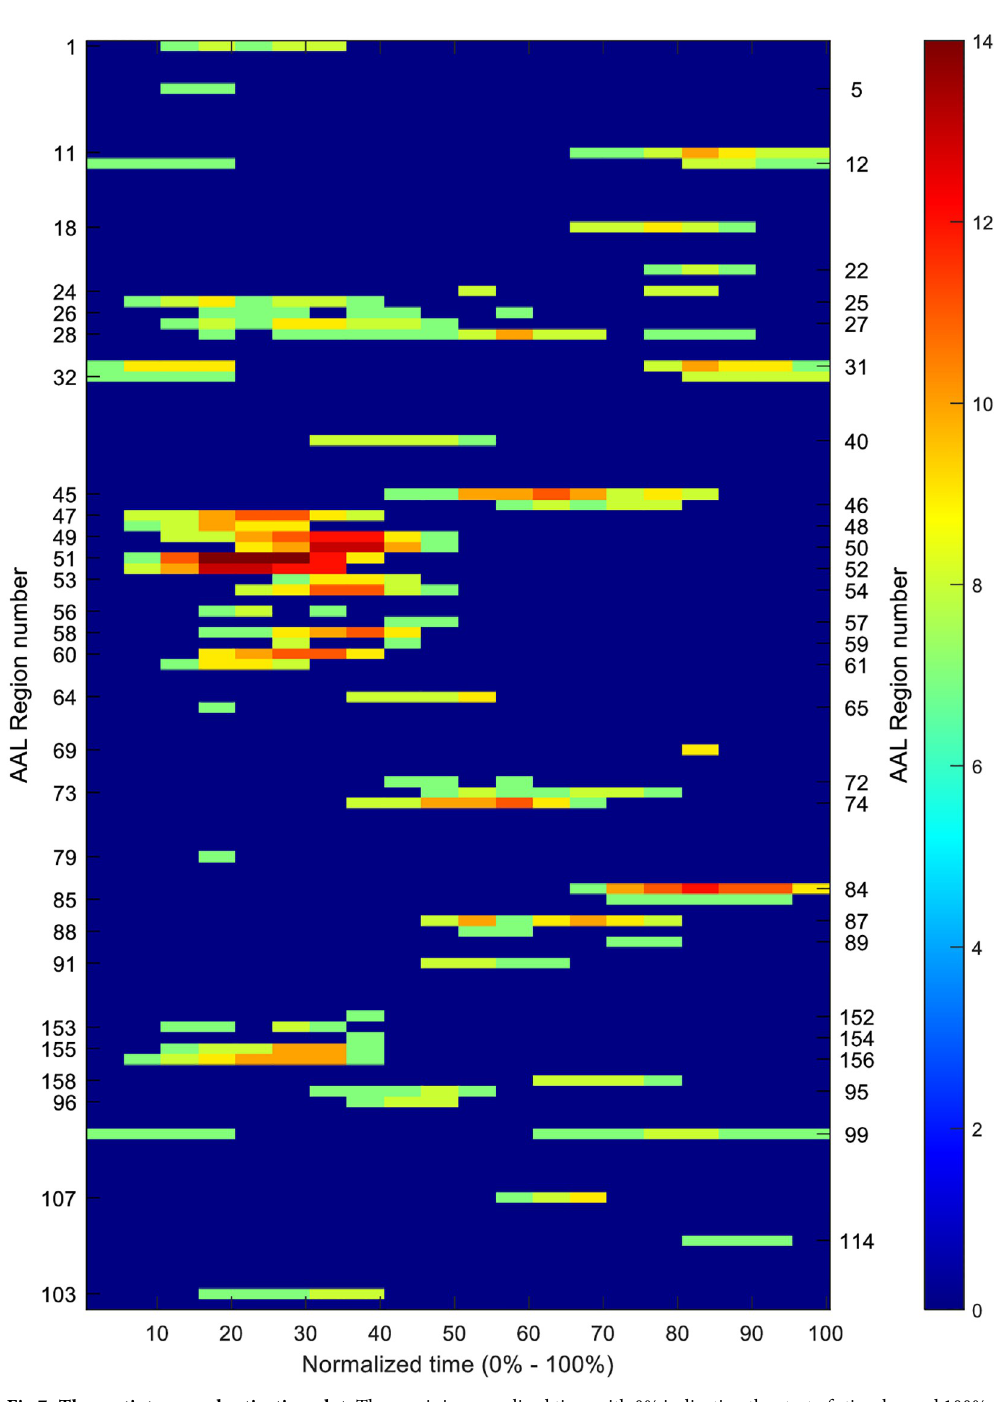
Fig 7. The spatiotemporal activation plot. The x-axis is normalized time with 0% indicating the start of stimulus and 100% indicating the end of stimulus. The y-axis shows AAL atlas ROI numbers. Each ROI number corresponds to a brain region. The color indicates the number of subjects for which significant activation is observed in each time window–ROI pair. The plot is thresholded at 7 so ROI activation consistent across at least 7 subjects is displayed.